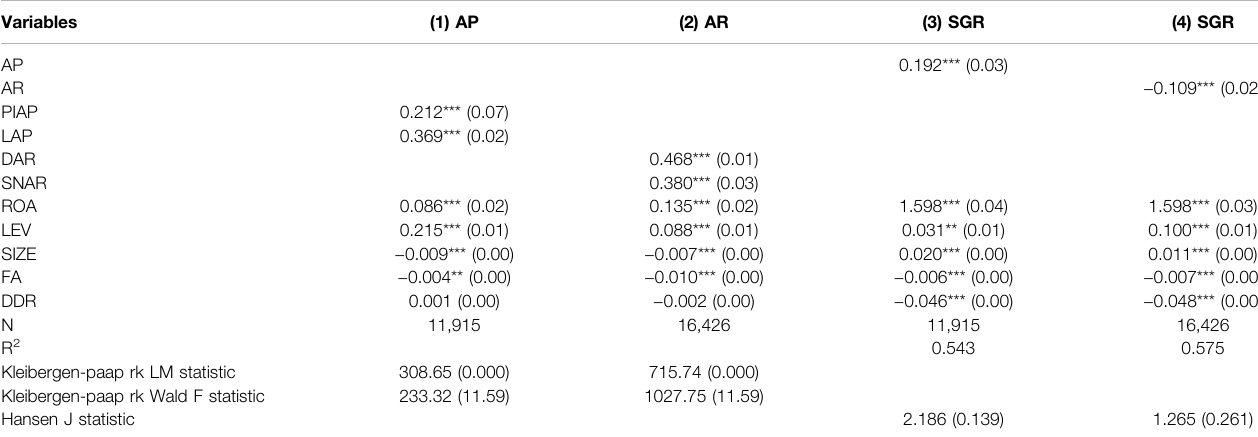
TABLE 10 | Regression results of instrumental variables.